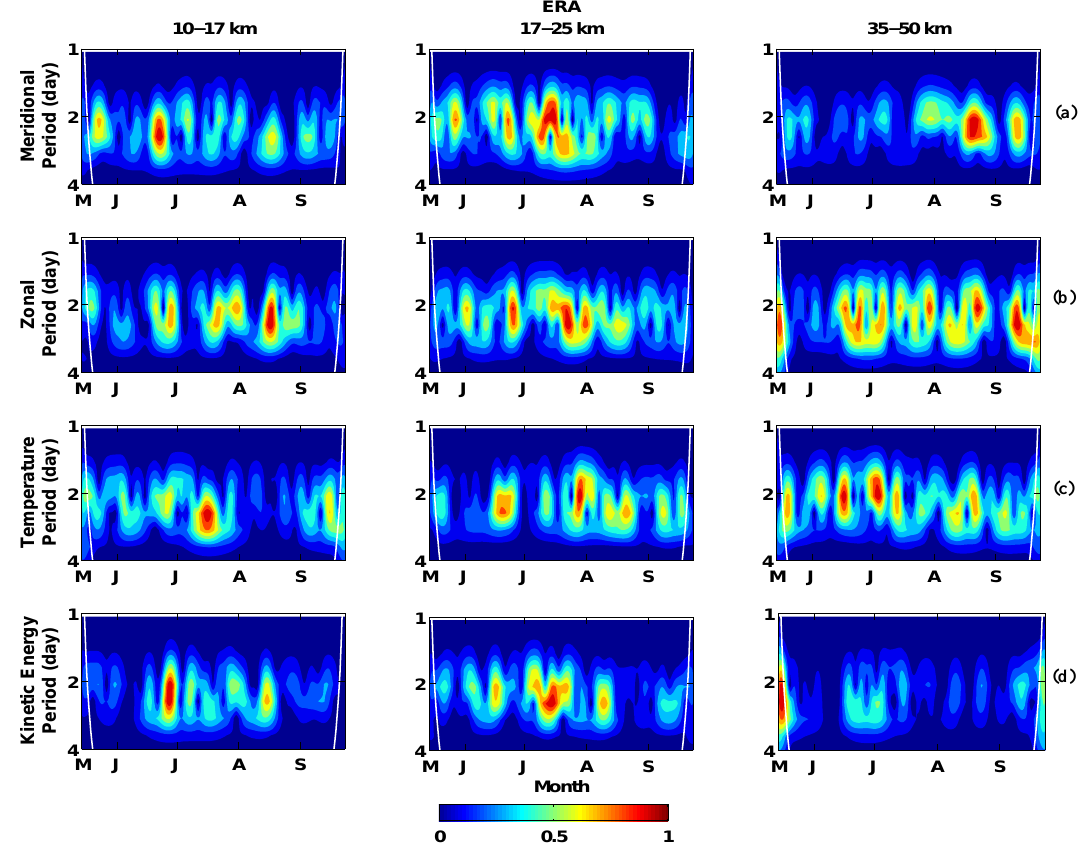
Fig. 7. Same as Fig. 6 but for 10–17km, 17–25km and 35–50km (ERA data).